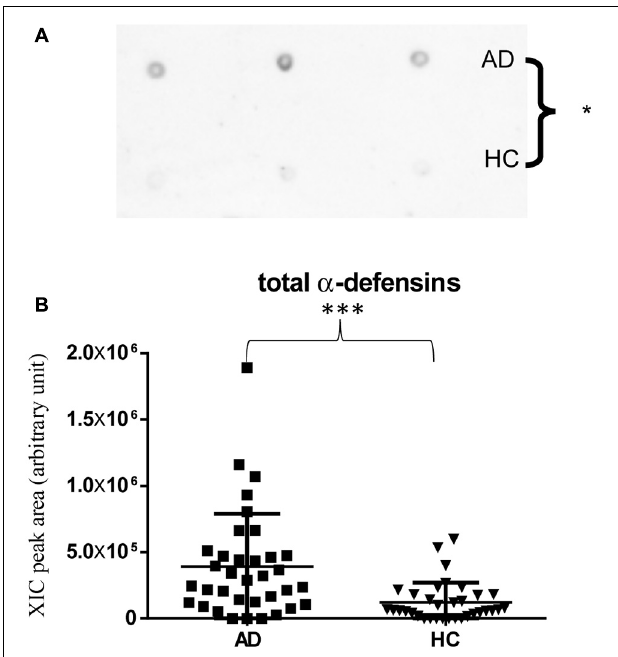
FIGURE 1 | Dot-blotting immunodetection of total α -defensins in salivary pools of AD and HC samples (A) and distribution plot of the XIC peak area values measured by HPLC-ESI-MS of total α -defensins (B) in each salivary sample from the AD and HC groups (XIC peak areas of the four identified defensins were considered in the sum, see Supplementary Table 2 ) ( ∗ , p < 0.05; ∗∗∗ , p < 0.001).